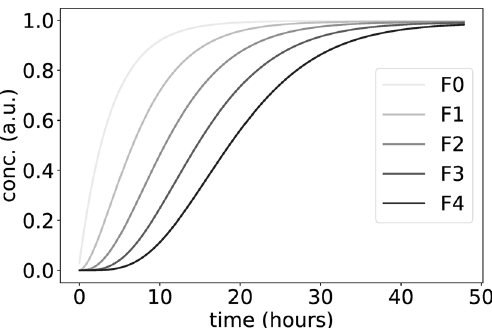
Figure 2. Modeling a delayed switch based on multiple phosphorylations: The simulations start with unphosphorylated protein F. The normalized total number of Fk with k = 1, . . . , 4 phosphorylations increases with time delays and hyperphosphorylated species (such as n = 4 ) accumulate in an ultrasensitive, switch-like